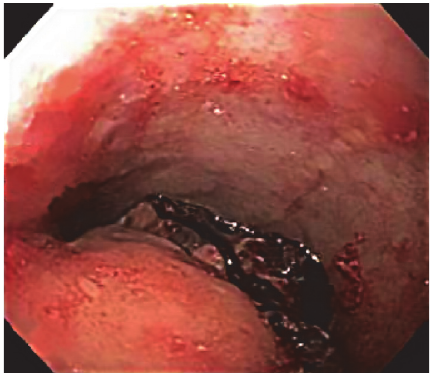
Figure 2: Esophagogastroduodenoscopy (EGD) showing submu- cosal tumor-like projection secondary to extrinsic compression of the upper esophagus with blood clot sitting on top of the compression at 5 cm below the upper esophageal sphincter